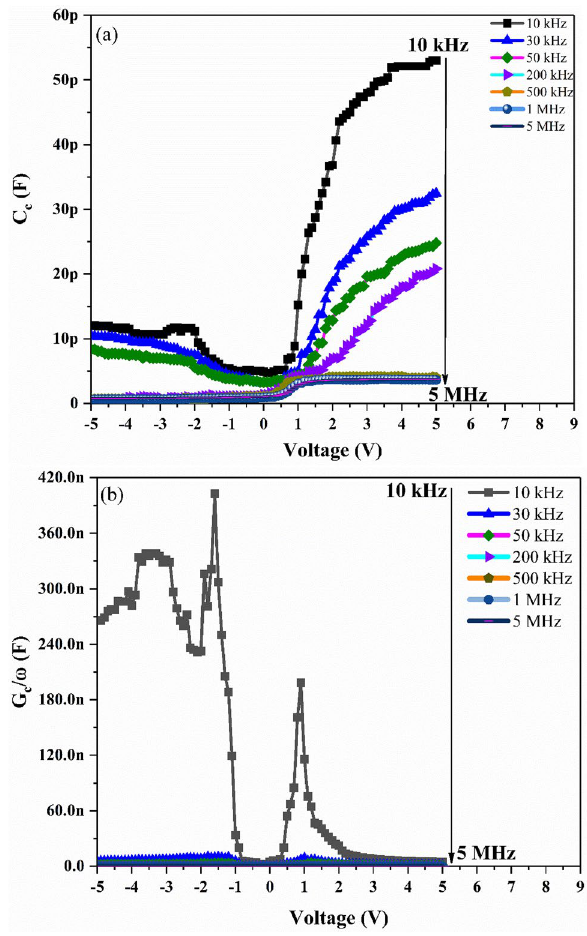
Figure 5. Plots of the ( a ) C C-V and ( b ) G c /ω–V for the Ag/TiO 2 -NW/Ge-NW/Si (MOS)